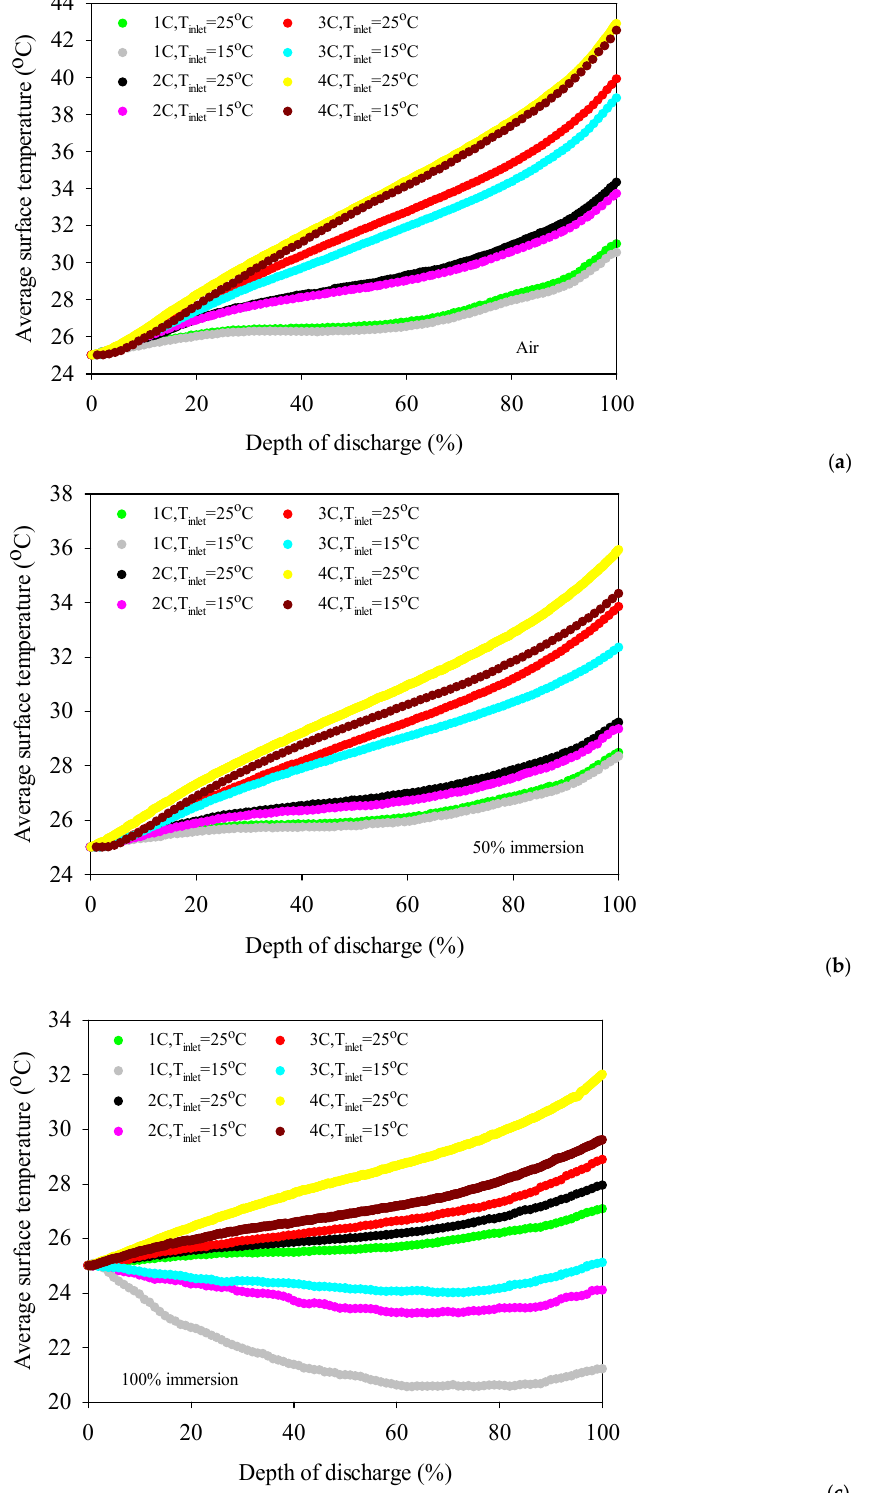
Figure 7. The effect of cooling fluid inlet temperature on average battery surface temperature for 1C ( a ) air, ( b ) 50% immersion, ( c ) 100% ( a ) air, ( b ) 50% immersion, ( c ) 100% immersion.